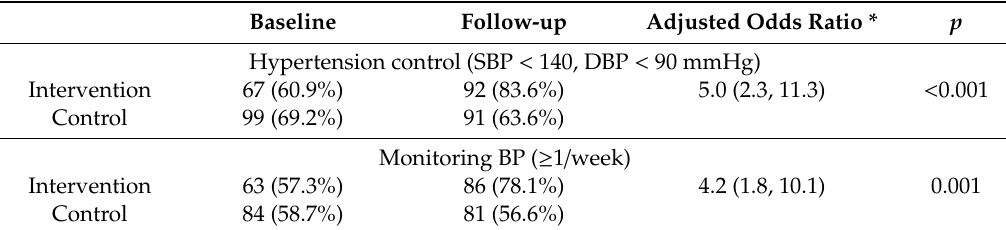
Table 3. Odds ratios (95% CI) in hypertension control and monitoring